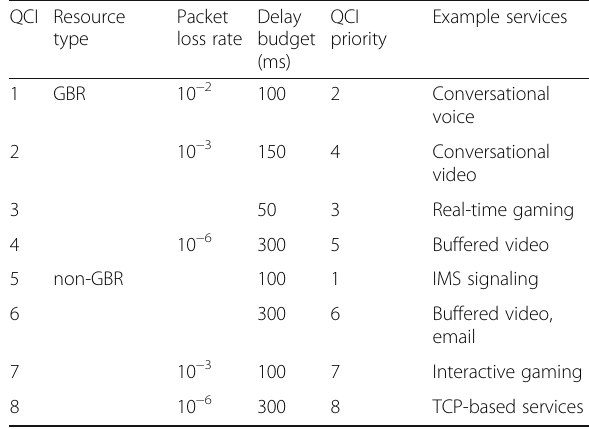
Table 4 LTE standard QCI